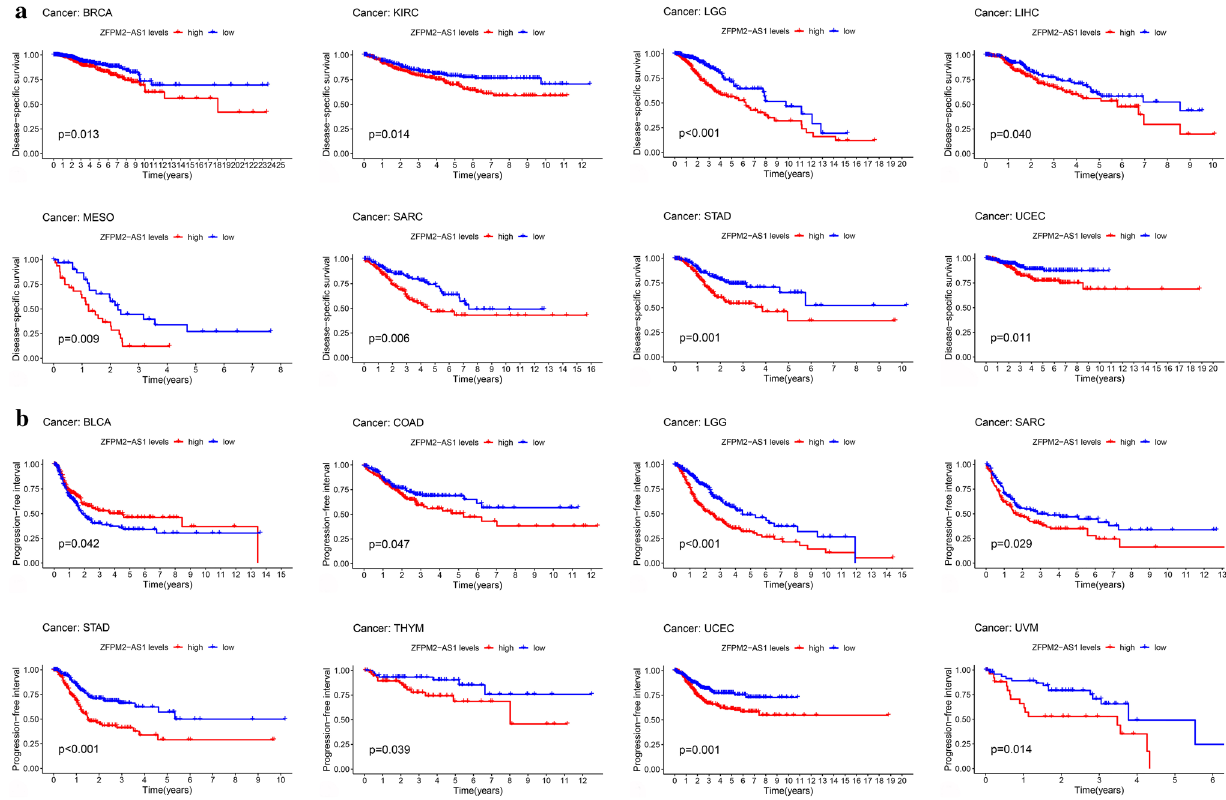
Fig. 5 The survival curve of ZFPM2-AS1 for DSS and PFI in pan-cancers. a The survival curve of ZFPM2-AS1 for DSS in pan-cancers. b The sur- vival curve of ZFPM2-AS1 for PFI in